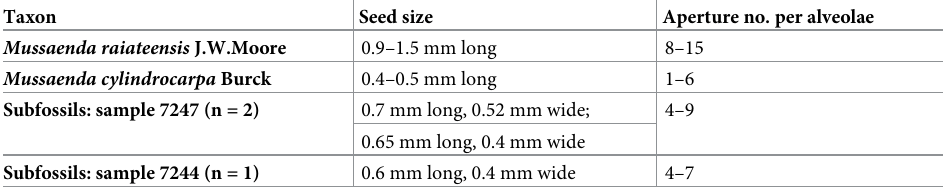
Table 6. Morphometric data for two modern Mussaenda species (Rubiaceae) from Gideon [115] and for measur- able Ho‘oumi